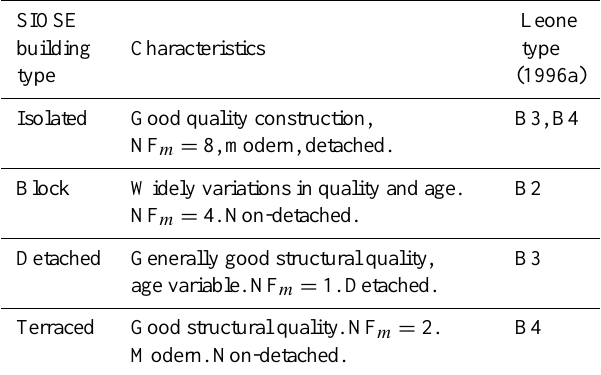
Table 8. Assigning building types according to Leone et al. (1996a).